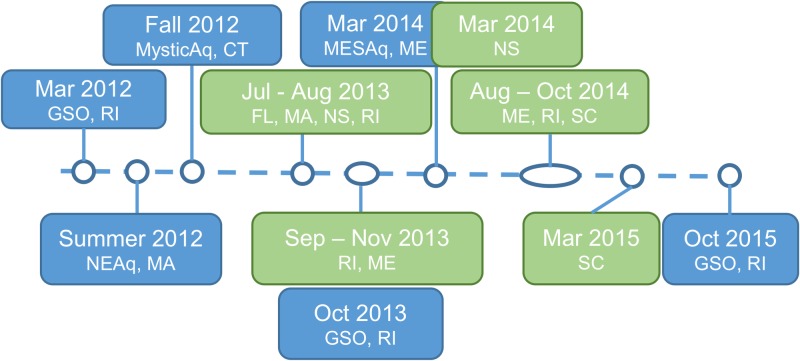
Timeline of SSWD events in sea stars on the Atlantic Coast of the USA.The timeline summarizes reports of events observed in aquariums (in blue) and citizen reports (green) in response to questionnaires administered in 2013 to 2015.